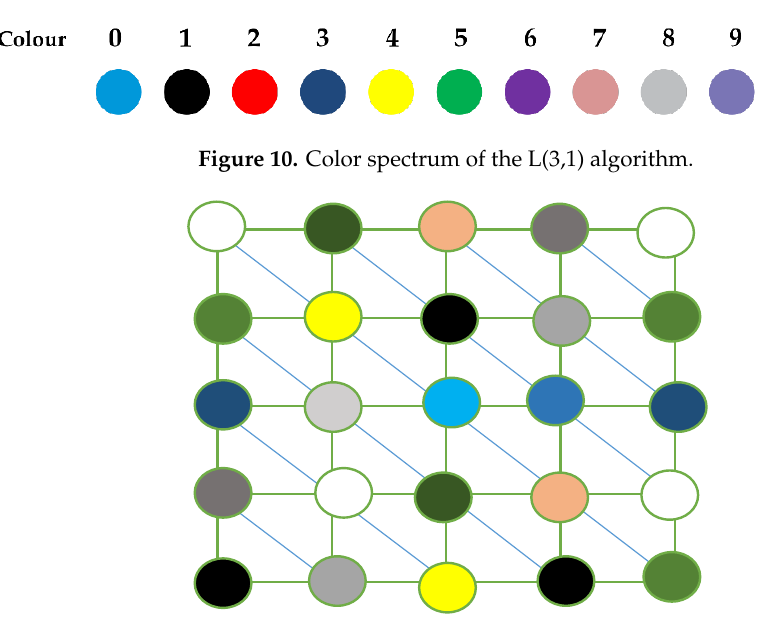
Figure 11. Cellular grid of a 5 × 5 matrix colored using the L(3,1) coloring.